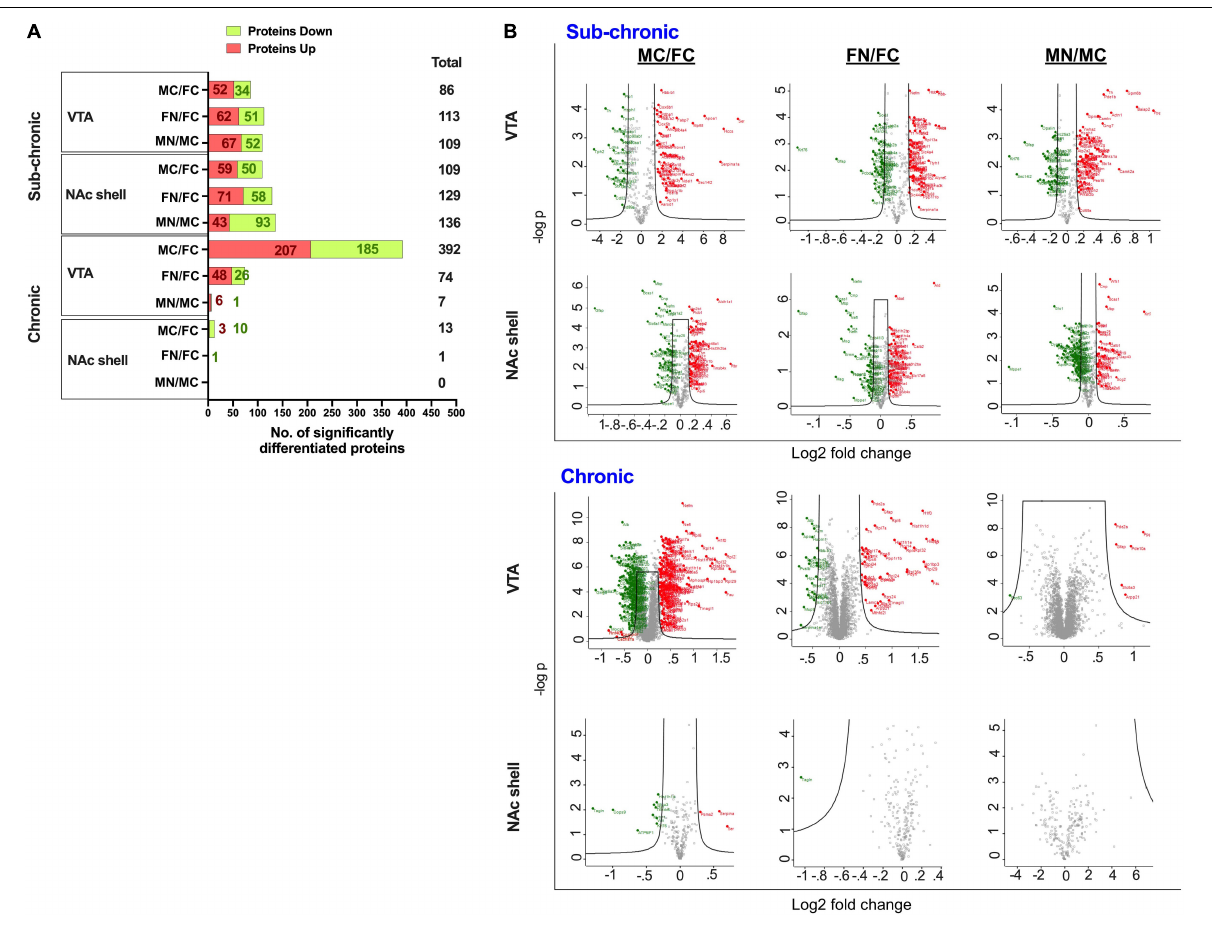
FIGURE 3 | Significantly altered proteins in pairwise comparisons between male vs. female and nicotine vs. control groups. (A) Summary of differentially regulated proteins in each pairwise comparison. (B) Volcano plots of log 2 fold change and –log 10 p -values are shown for each pairwise comparison in VTA and NAc shell after sub-chronic or chronic nicotine administration in C3H/HeJ or C57BL/6J mice. Black lines within the graph show the significance cutoffs as determined in Perseus with s0 = 0.5 and FDR < 0.05. Proteins meeting significance criteria are colored. Red indicates an increase in protein abundance, and green indicates a decrease in protein